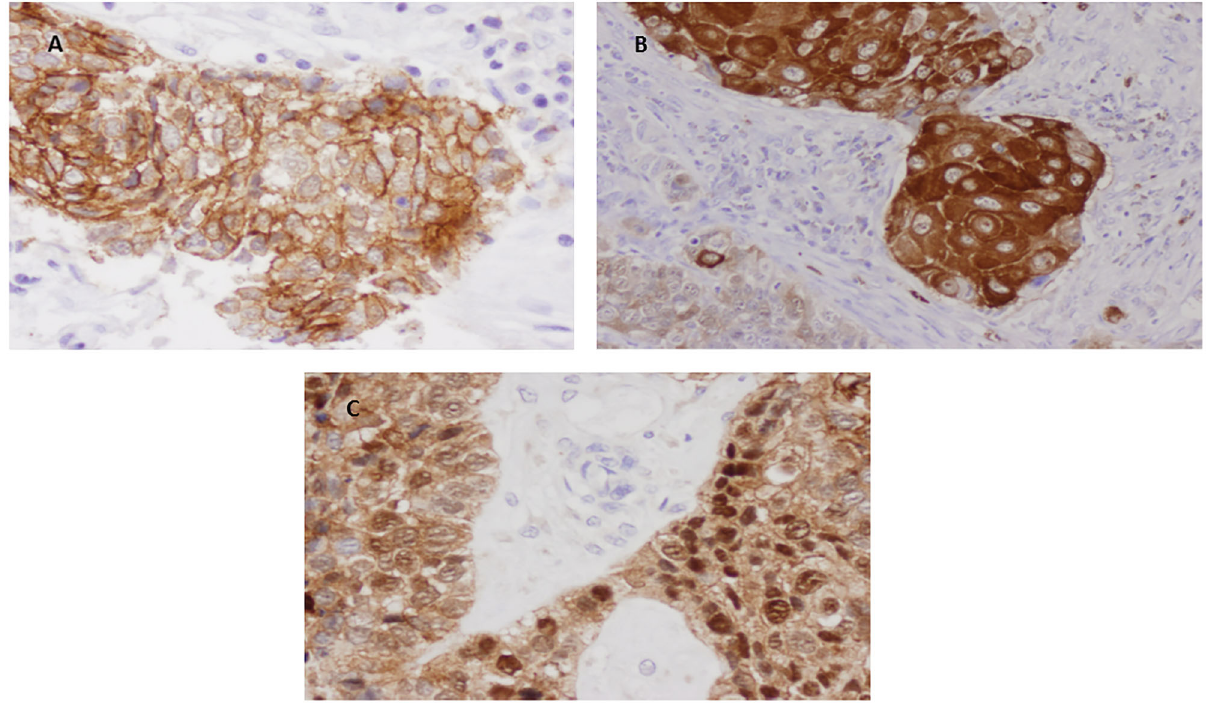
Figure 1. Immunohistochemical staining of PKP1 in SCC. (A) Predominant staining in cell membrane a (40 (cid:5) ). (B) Positivity in membrane and cytoplasm. Note weak staining in less differentiated area (bottom left) (20 (cid:5) ). (C) Nuclear staining (40 (cid:5) ).